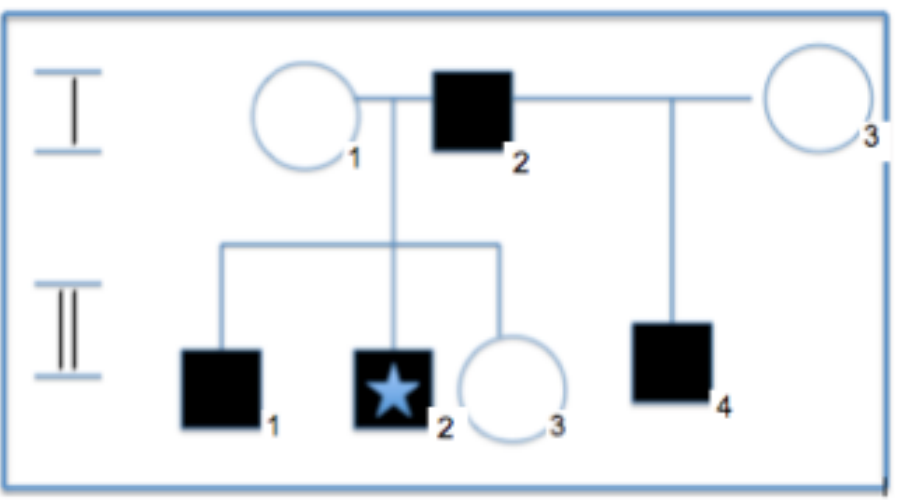
Figure 1. A pedigree shows that the males in generations II and I are affected by premature hypopigmentation. Individual II.4 is also affected, regardless of the fact that his maternal genome differs from the other progeny in the second generation. The individual of the case report, II.2 is demarcated with a “star”.